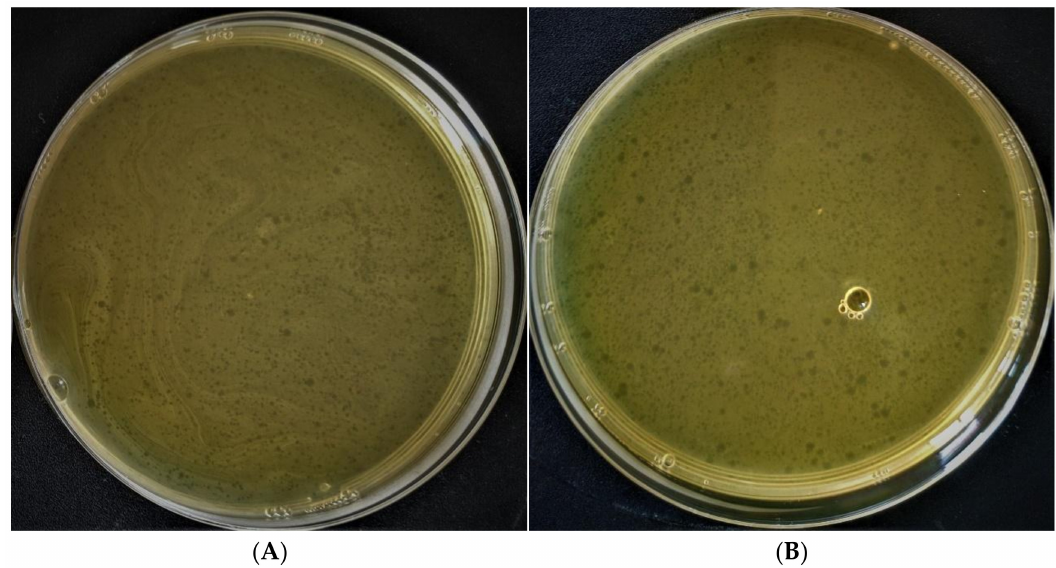
Figure 2. Influence of the alkaline medium on survival of bacteriophages. ( A ) Medium with pH 9.02; ( B ) medium with pH 5.5.